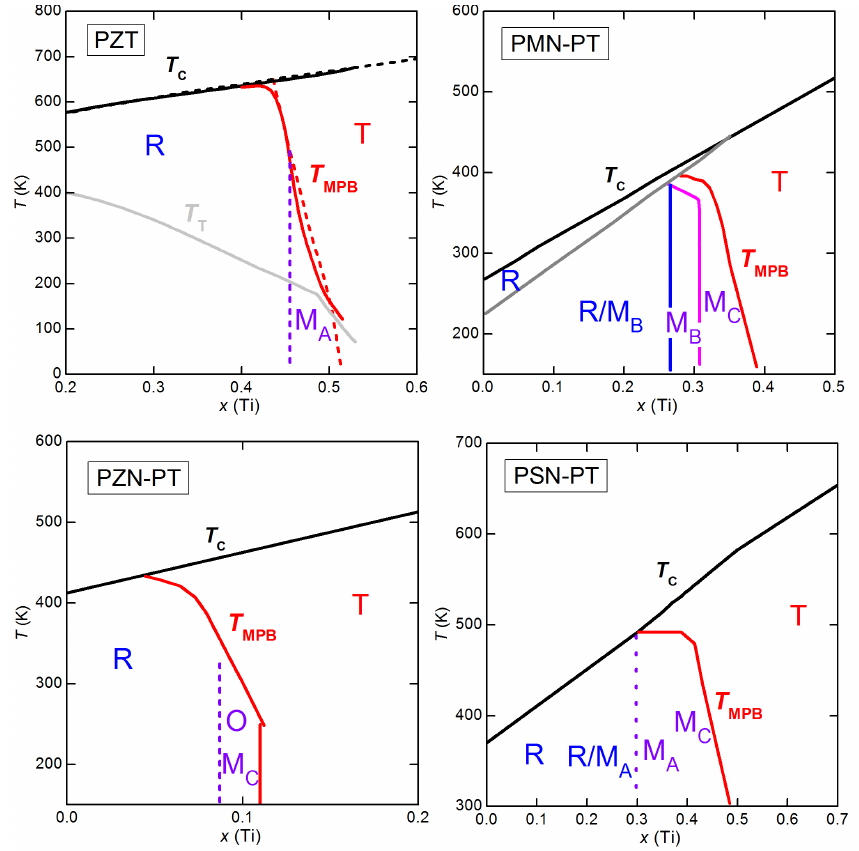
Figure 15. Phase diagrams of four solid solutions of PbTiO 3 (PT) with antiferroelectric PZ and relaxor Pb(Mg 1/3 Nb 2/3 )O 3 (PMN), PbZn 1/3 Nb 2/3 O 3 (PZN) and PS. PZT: the continuous and dashed lines Ref. [126]; PZN-PT from [8]; PSN-PT from